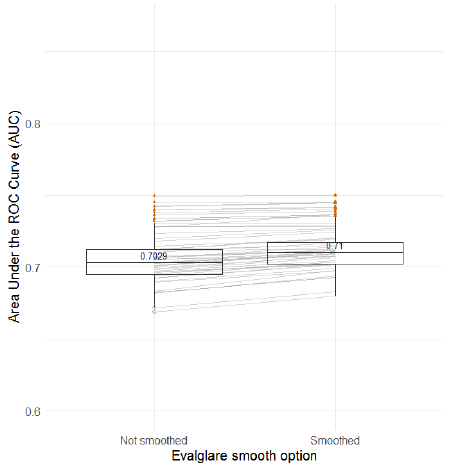
Figure 34. Boxplots of AUC for the non-smooth/smooth parameter (field study).